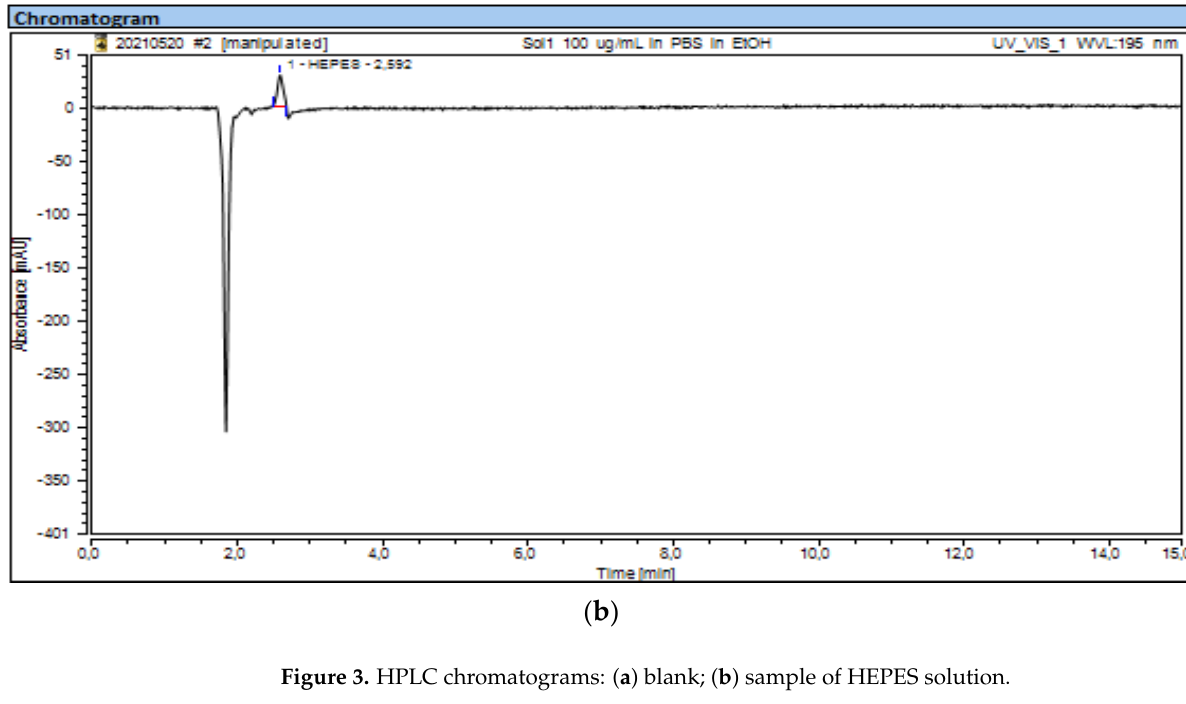
Table 1. Effect of different solvents on HEPES retention time. Solvent